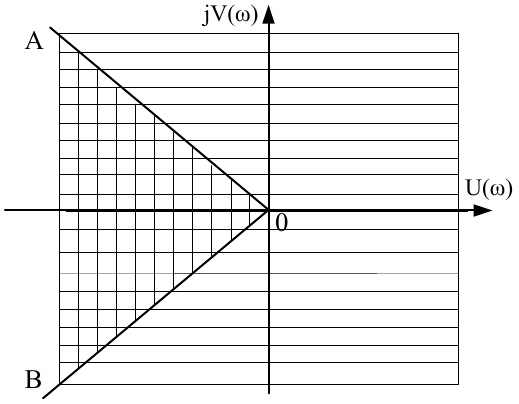
Figure 33. Polynomial basis j 2/3 —sector (cid:4672) 𝝅 are out of the sector, the system is stable.